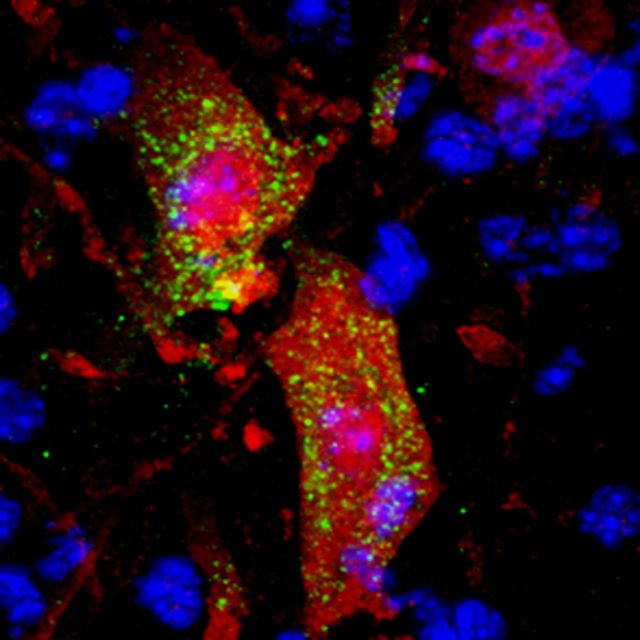

See van Doorn and Jacobs (doi:10.1093/brain/aww078) for a scientific commentary on this article.  
How does anti-ganglioside autoantibody clearance from the circulation affect their detection and neurotoxicity? Cunningham et al. describe an uptake pathway for these autoantibodies at motor nerve terminals and their delivery into the brain parenchyma. This highlights the limitations of serum antibody measurements and suggests a possible entry mechanism for their central effects.